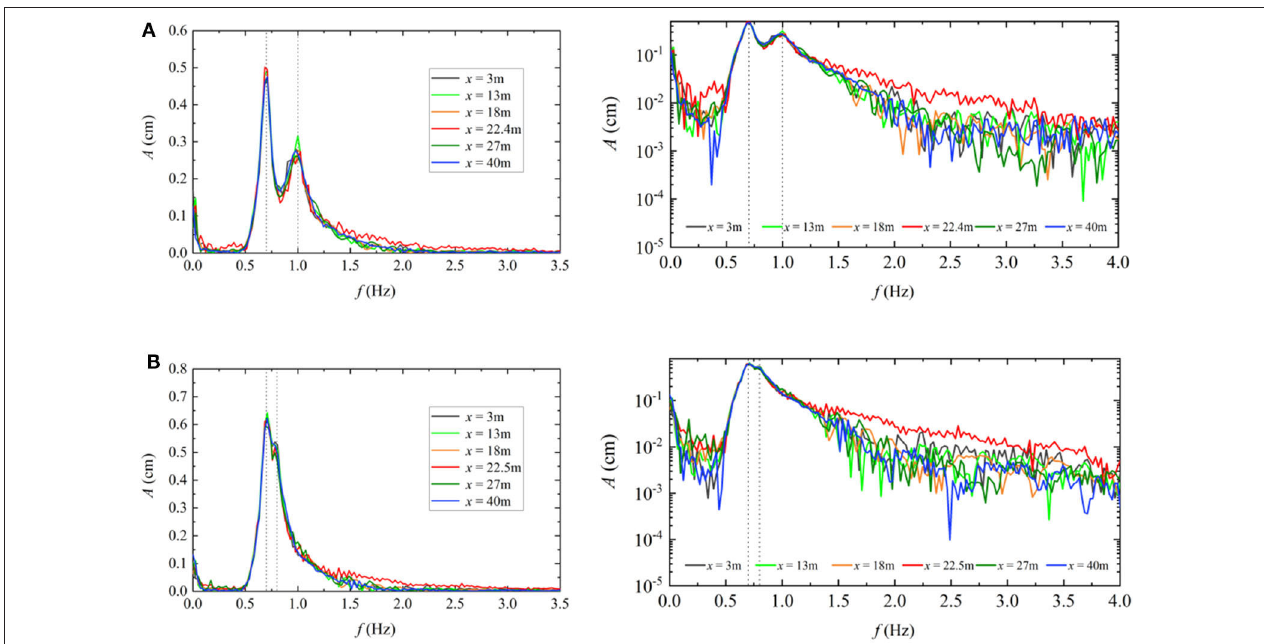
FIGURE 7 | The amplitude spectra at different locations along wave flume for (A) Case 2_AB and (B) Case